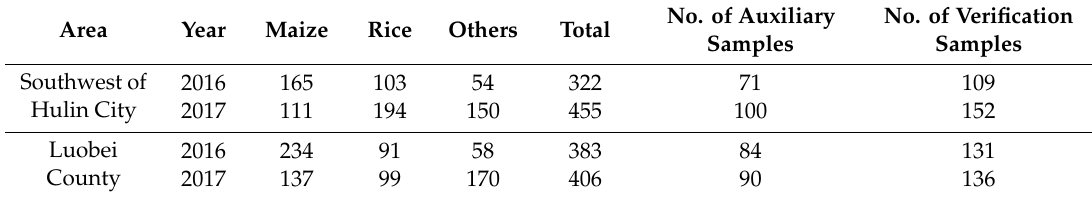
Table 2. Details of the ground reference